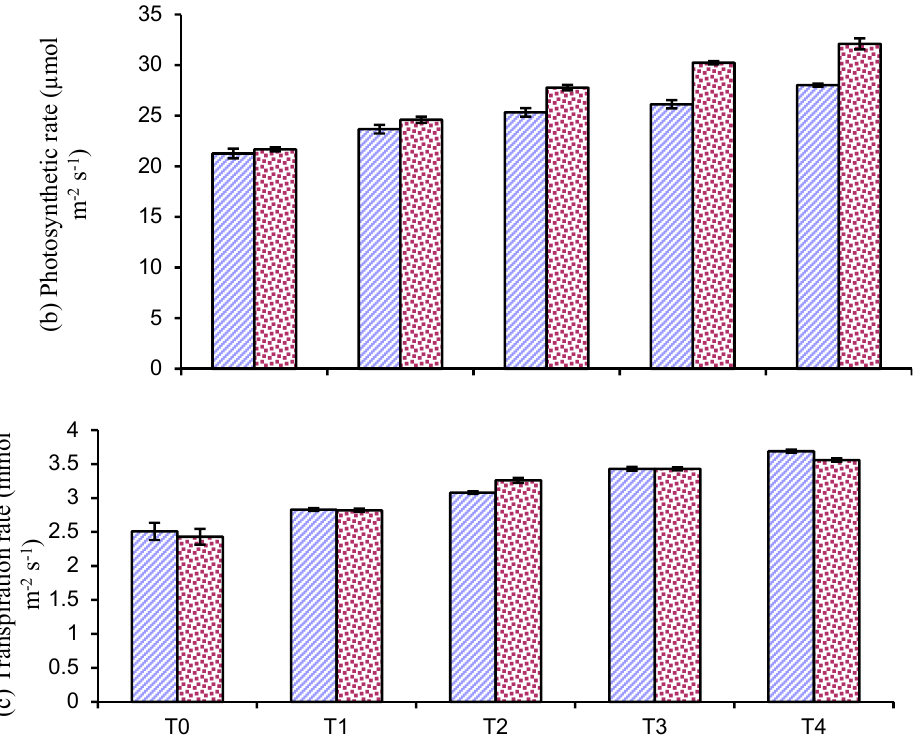
Figure 2. Effect of varying application rates of phosphatic fertilizer on physiological responses of coarse and fine rice ( Oryza sativa L.) receiving city effluent irrigation (Each value is a mean, n = 3 statistically significant at p ≤ 0.05, T bars represents ± SE of means i.e., SEMs). Whereas, T 0 = Control, T 1 = N 170 P 62 K 62, T 2 = N 170 P 124 K 62, T 3 = N 170 P 186 K 62, T 4 = N 170 P 248 K 62.